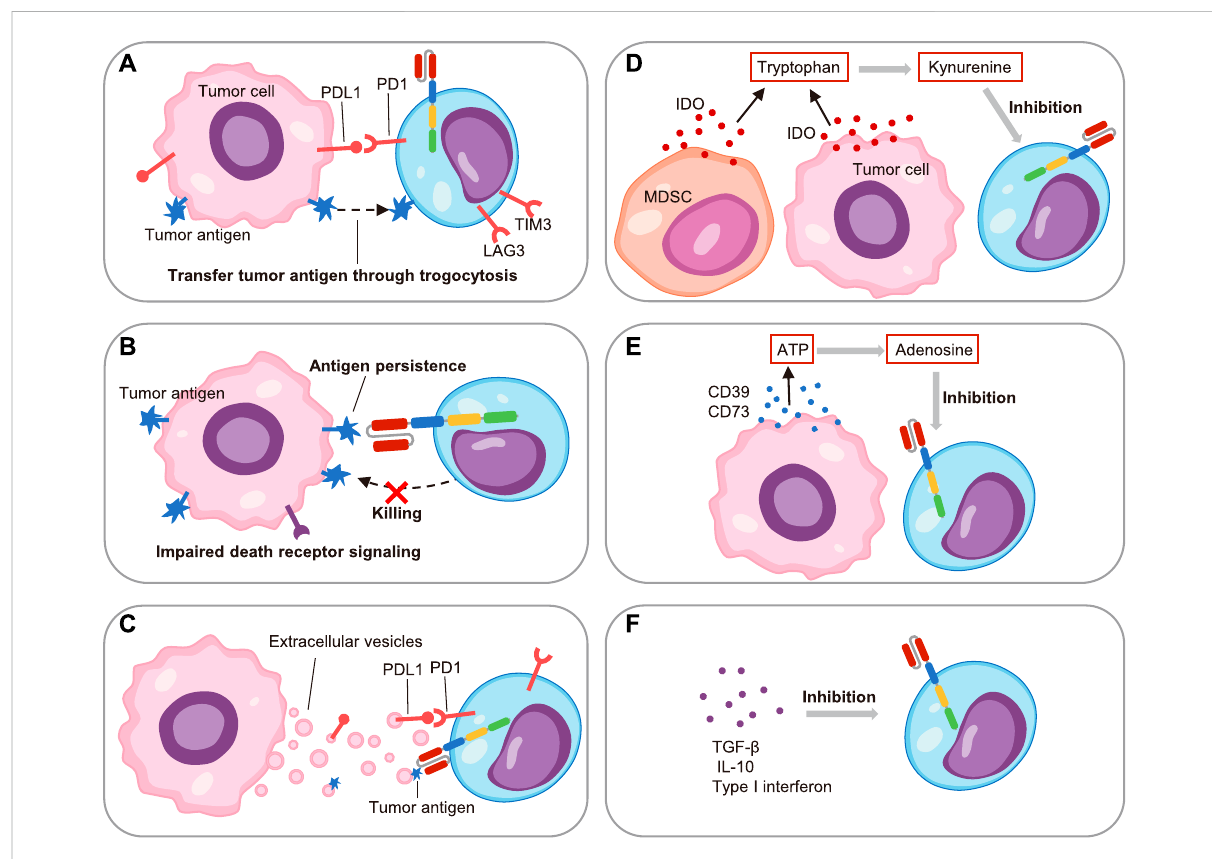
FIGURE 3 The factors promoting CAR T cell exhaustion in the tumor microenvironment. (A) On one hand, the PDL1 on tumor cells induced CAR T cell exhaustion through PD1/PDL1 pathway; on the other hand, the tumor antigen transferred to CAR T cells through trogocytosis and caused exhaustion. (B) The impaired death receptor signaling of leukemia cells led to their resistance to CAR T cells, and the persistent antigen in turn led to CARTcellexhaustion. (C) TheextracellularvesiclessecretedbyleukemiacellsinducedCARTcellexhaustionthroughPDL1andtumorantigen. (D) The myeloid-derived suppressor cells (MDSC) and leukemia cells secreted indoleamine 2,3-dioxygenase (IDO), which catalyzed tryptophan to kynureninetosuppressCARTcellfunction. (E) TheCD39andCD73releasedbytumorcellshydrolyzedATPtoadenosine,whichinhibitedCARTcell activity. (F) Soluble factors including TGF- β , IL-10 and type I interferon restrained CAR T cell